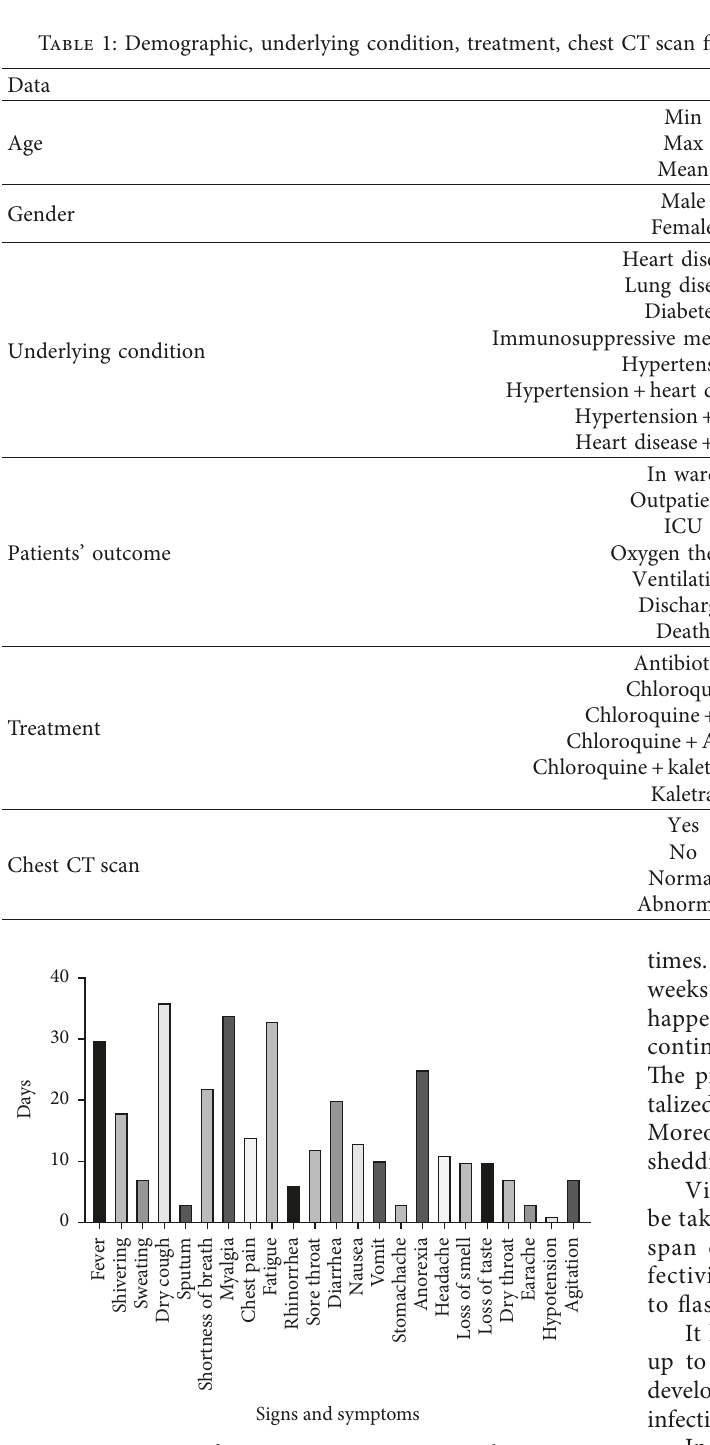
Figure 1: Frequency of COVID-19 patients signs and ond/third PCR positivity results ( P value = 0.84, P value = 0.118)